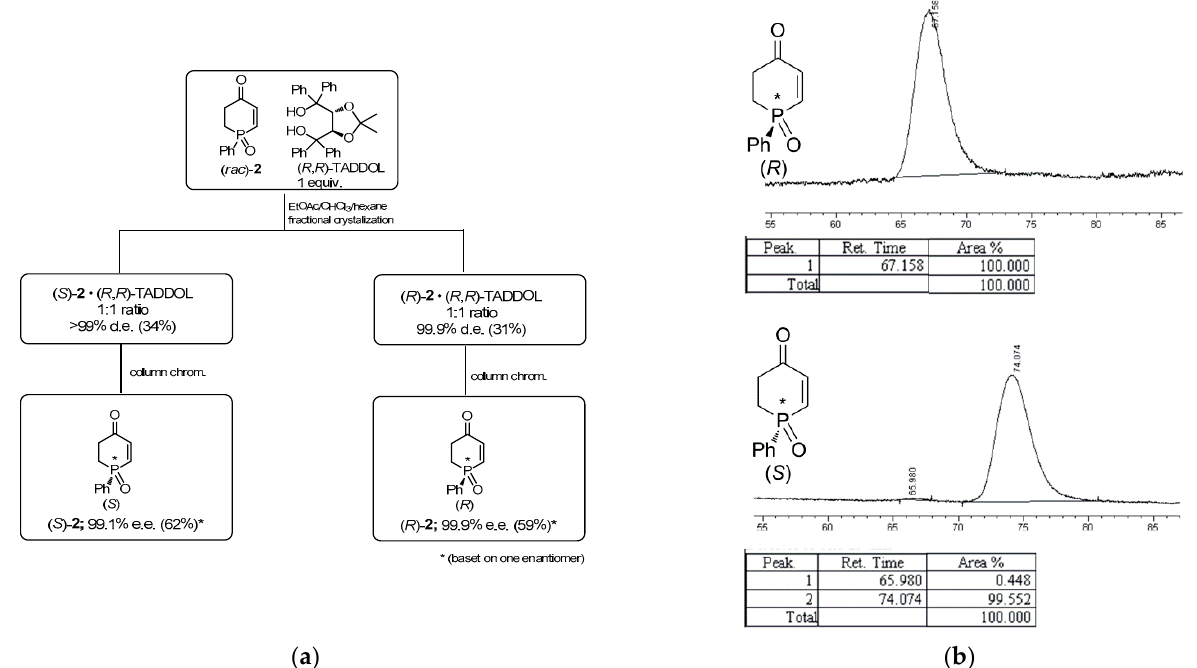
Figure 12. ( a ) Liberation of the enantiomers of phosphin-2-en-4-one 2 on silica gel columns; ( b ) copies of CSP-HPLC traces of ( R )- 2 and (S)- 2 (CHIRALCEL-OD-H).